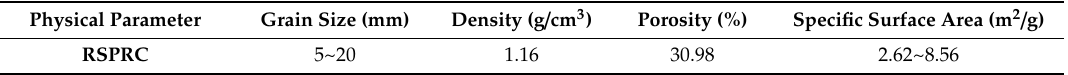
Table 4. Physical properties of RSPRC used in experiments.